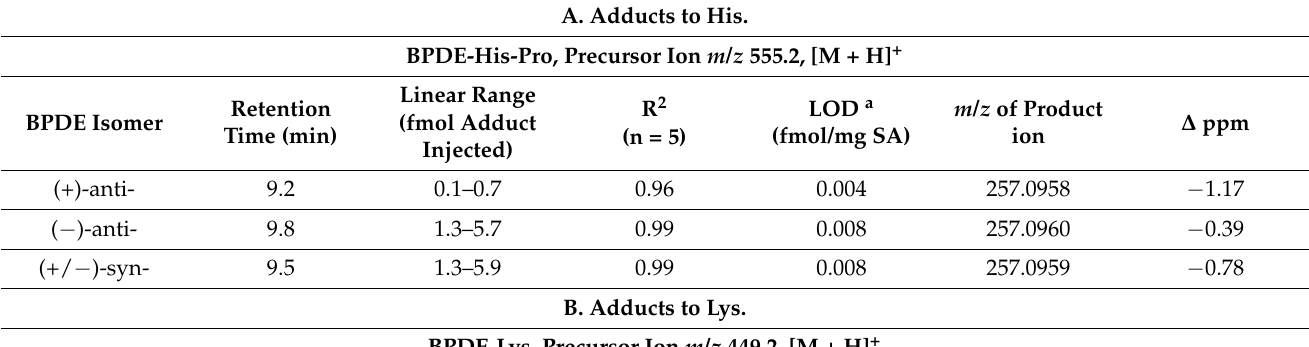
Table 2. Method evaluation parameters, calculated for the different BPDE adducts to His (A) and Lys (B) using in vitro alkylated human SA in solution. A. Adducts to